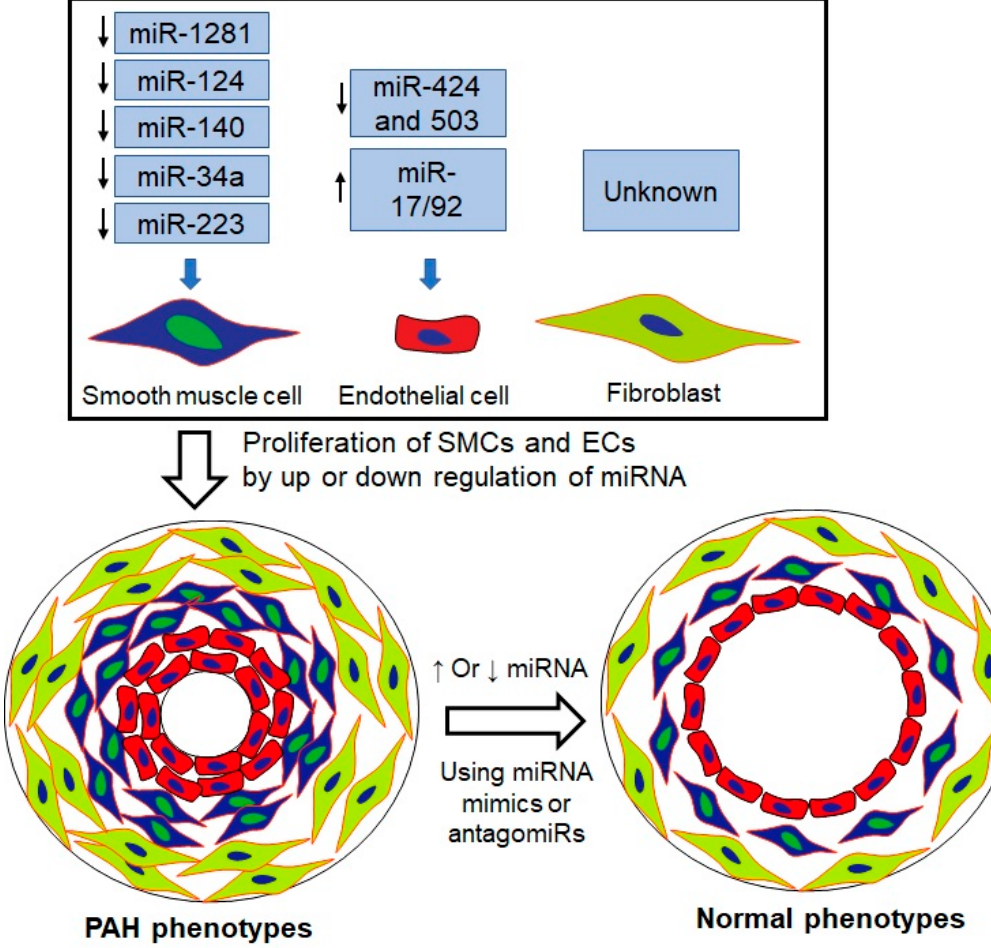
Figure 4. Targeting miRNAs can revert the phenotype of PAH to normal by inhibiting cell proliferation. During PAH pathogenesis, the expression of several miRNAs (miR-1281, miR-124, miR-140, miR34a, and miR-223) in smooth muscle cells of pulmonary artery is downregulated, while that of others (miR-424 and 503 and miR-17/92) is down and upregulated in endothelial cells. However, miRNA expression in the fibroblast still remains to be clarified. Under up- and downregulated conditions, the proliferation of cells, including smooth muscle, endothelial, and fibroblast cells within the pulmonary artery, occurs and, in turn, narrows the artery and decreases blood blow, while increas- ing the pressure, leading to PAH pathogenesis. Delivery of miRNA mimics to the downregulated miRNAs or that of antagomiRs to the upregulated miRNAs in these cells could be a possible way to return the situation to